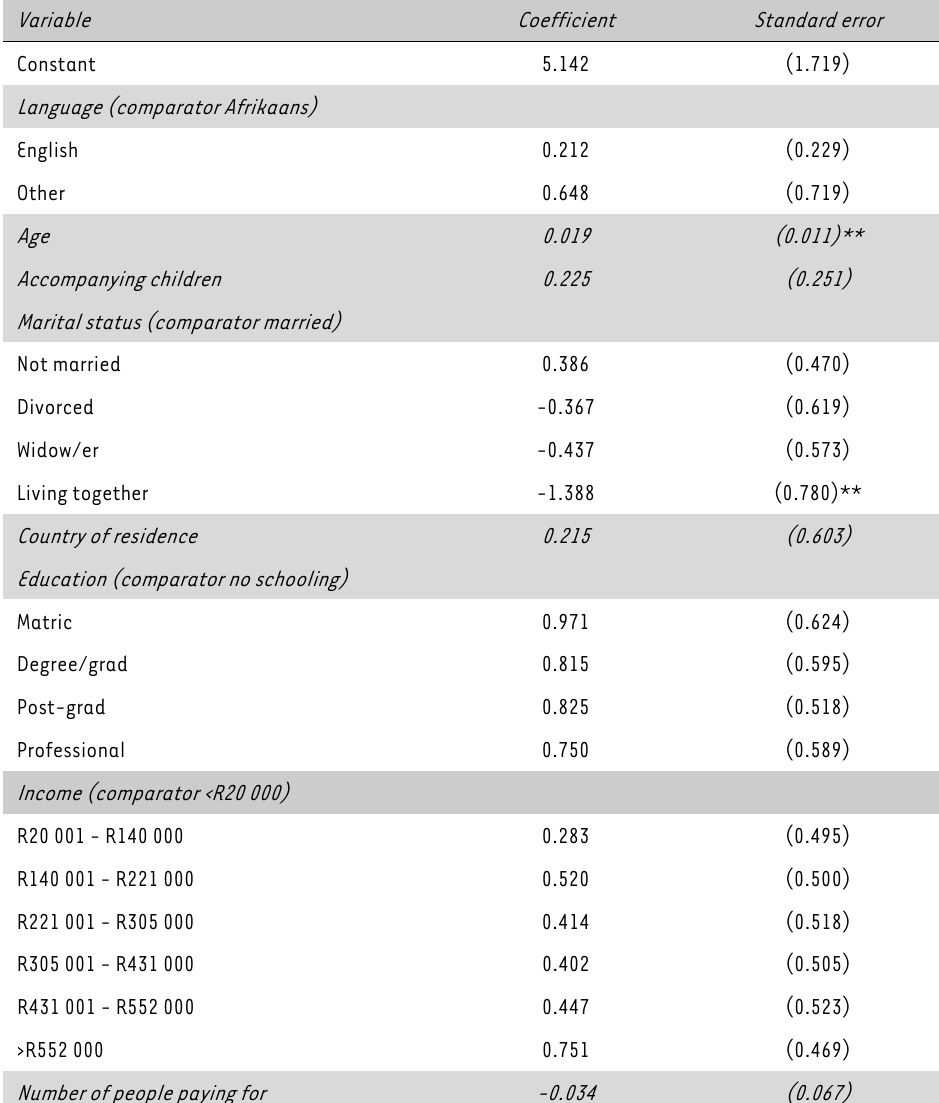
TABLE 2: Results of the OLS regression model with the dependent variable log (WTP) (total amount willing to pay to see the Big5) with standard errors in